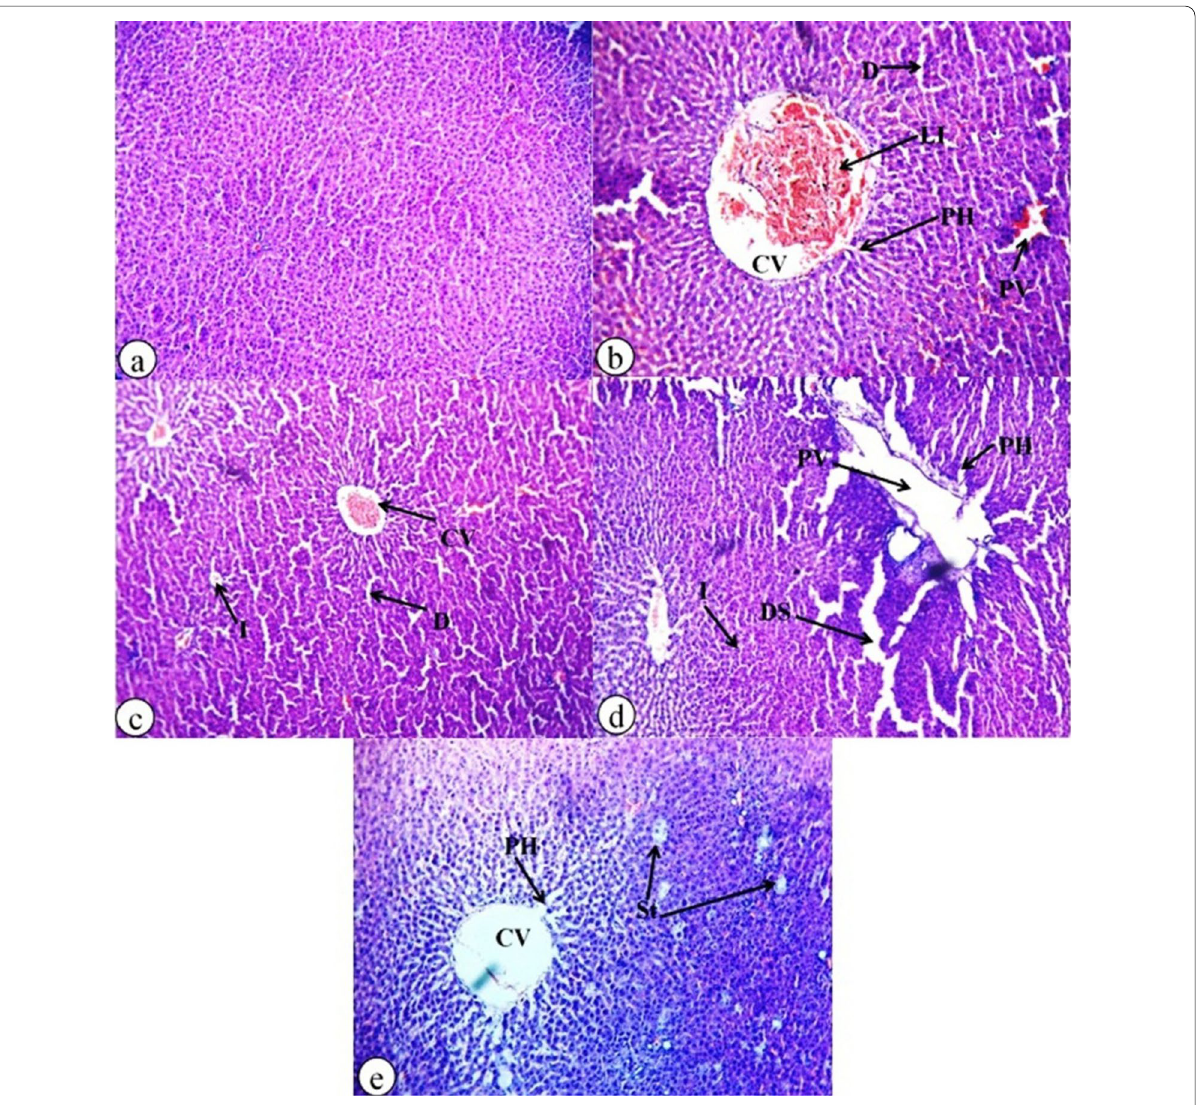
Fig. 5 Photomicrograph of the effect of administration of ethanolic extract of L. rugosa on the histology of the liver; a Normal control; b paracetamol hepatotoxic control; c paracetamol hepatotoxic treated with silymarin; d paracetamol hepatotoxic treated with 200 mg/kg b.w LR; e paracetamol hepatotoxic treated with 300 mg/kg b.w LR. I: inflammation; PH: periportal hypertrophy; D: deterioration of hepatic parenchyma; DS: dilation of sinusoidal capillary; LI: leukocyte infiltration; CV: central vein; PV: portal vein, St: